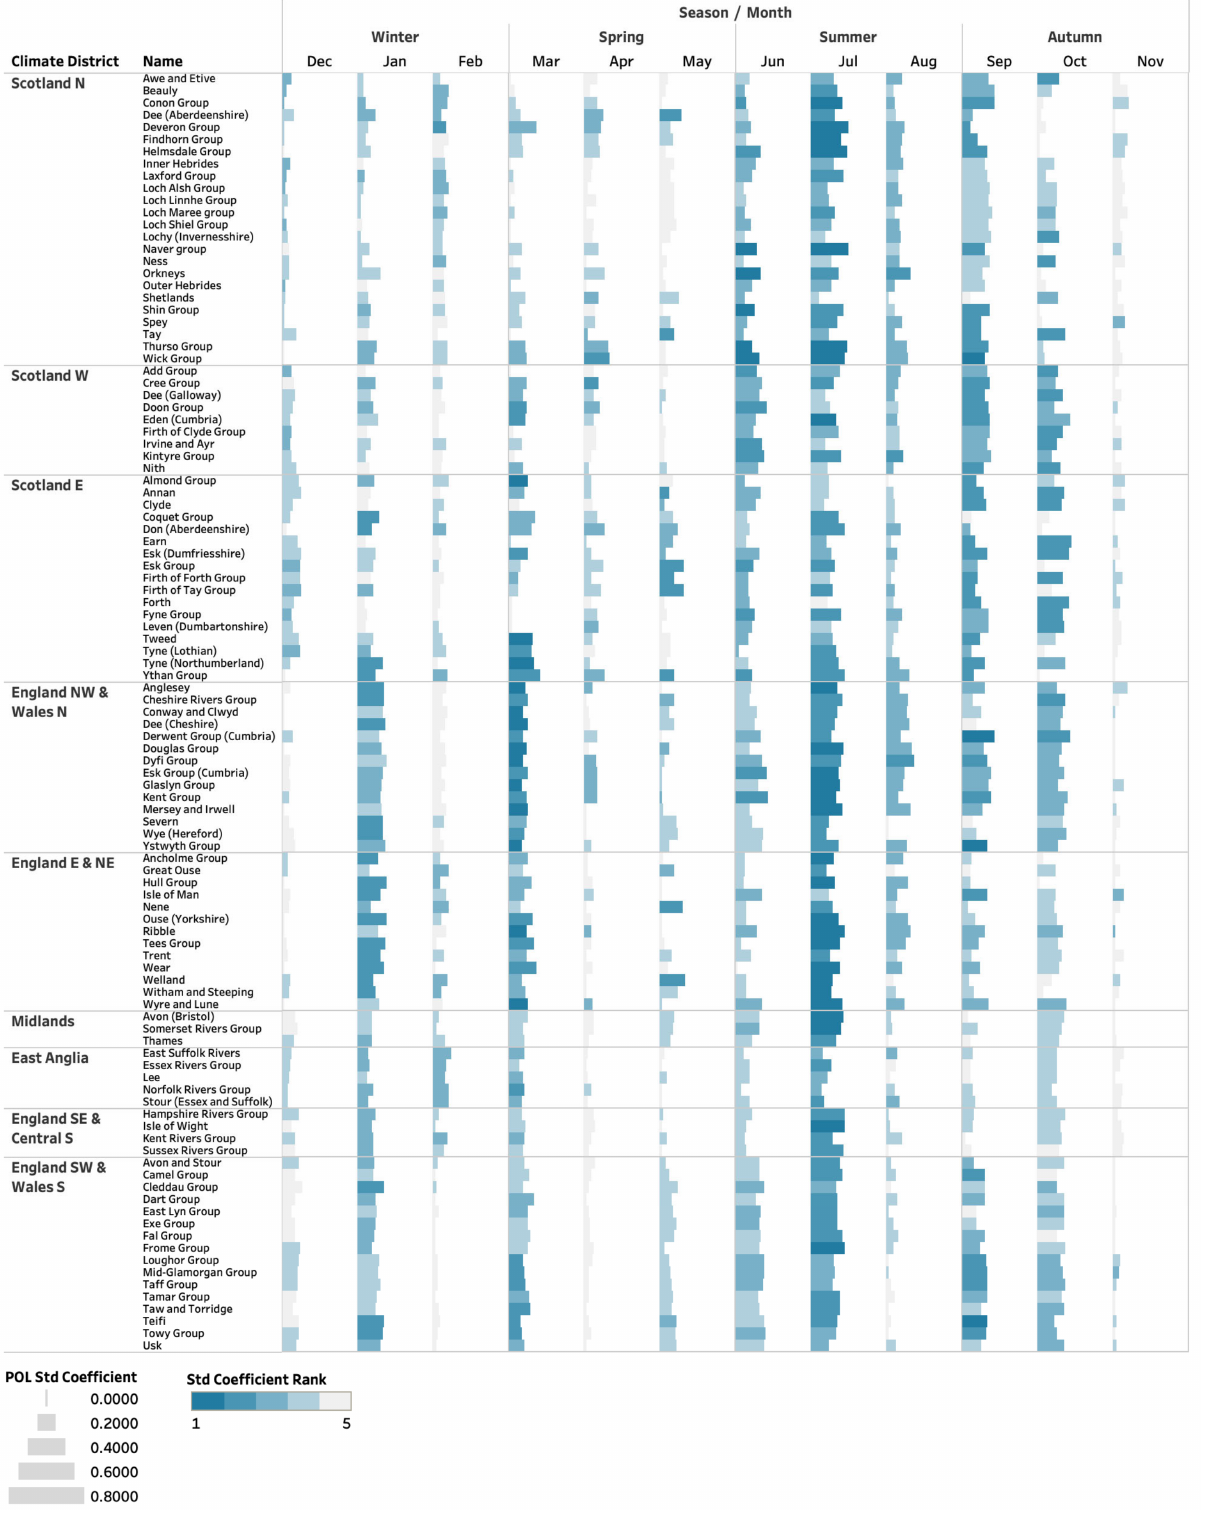
Figure A8. Rank of the POL Standardised Coefficient. Colour represents the rank, with darker colours signifying greater influence (higher rank). Size is dependent on the magnitude of the